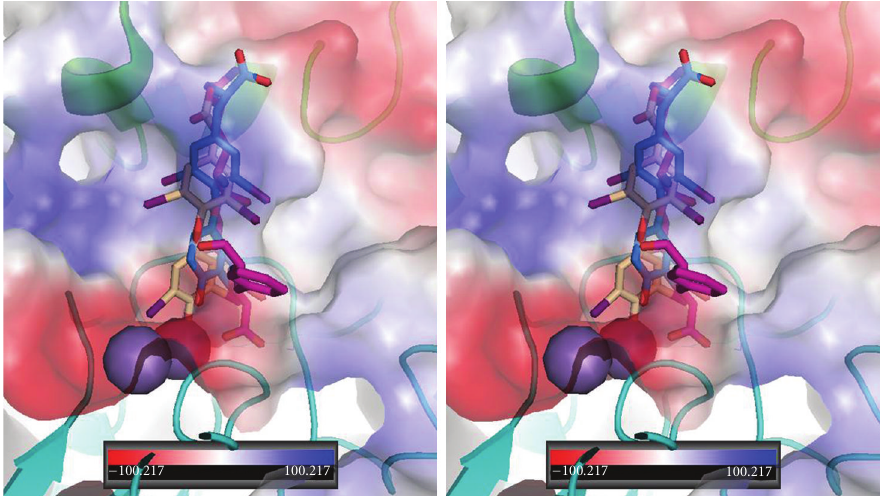
Figure 6: Stereoview of QM/MM model for T 3 (blue-Ca2) and T 4 ac (beige) bound in α v β 3 integrin at the RGD peptapeptide (violet) binding site. The electrostatic surface for integrin is shown. Red is negative and blue is positive surface. α v domain is green and β 3 domain is cyan. Spheres (purple/violet) are Ca 2+ /Mg 2+ . Figure drawn with PyMol.